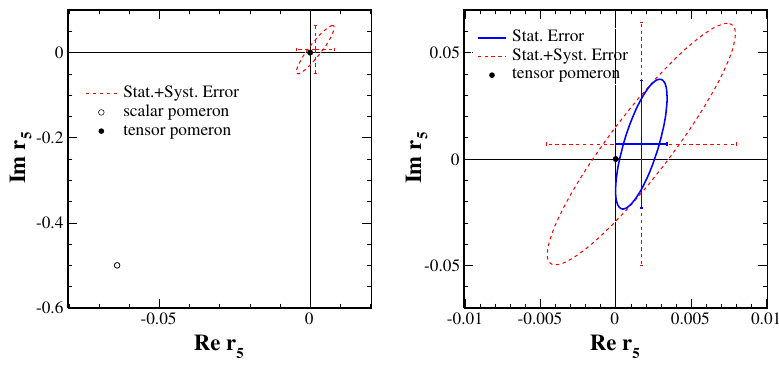
√ s = 200 GeV from Fig. 5 of [11] together with the results